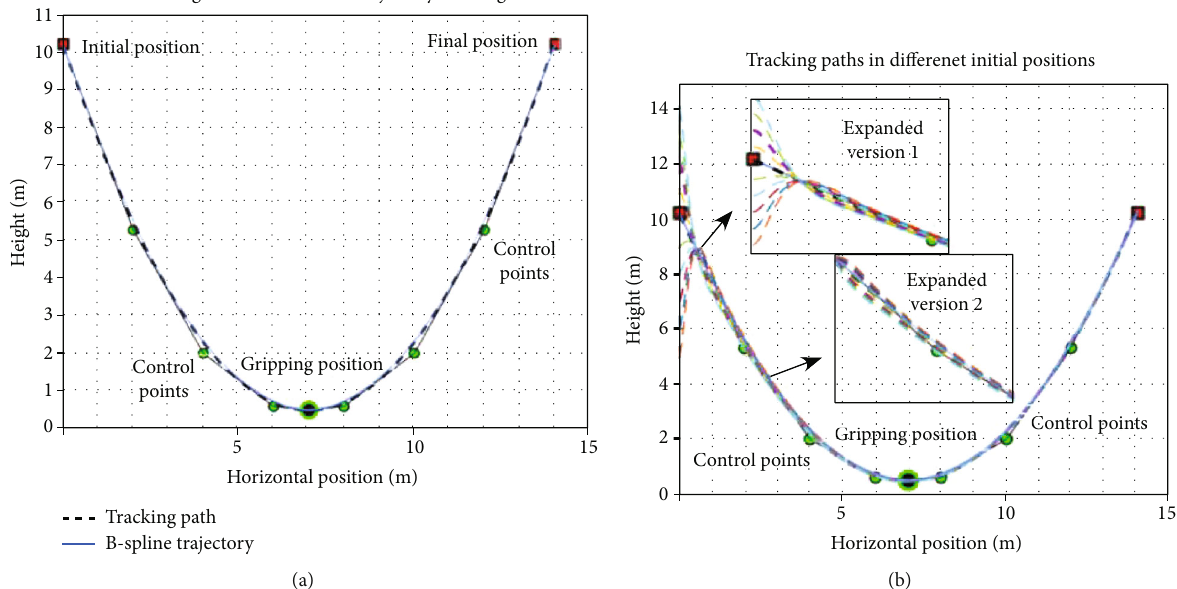
Figure 13: In fl uence of initial position on tracking e ff ect. (a) Trajectory tracking control. (b) Tracking trajectories at di ff erent initial positions.